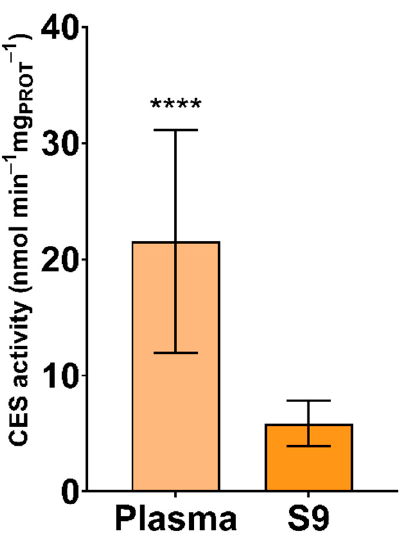
Figure 2. Specific activity of carboxylesterase (CES) in plasma and S9 (nmol min − 1 mg PROT − 1 ) of white stork ( C. ciconia ) nestlings ( n = 16), presented as the mean ± SD. Statistical difference is indicated with **** (Welch’s t -test, p < 0.0001).